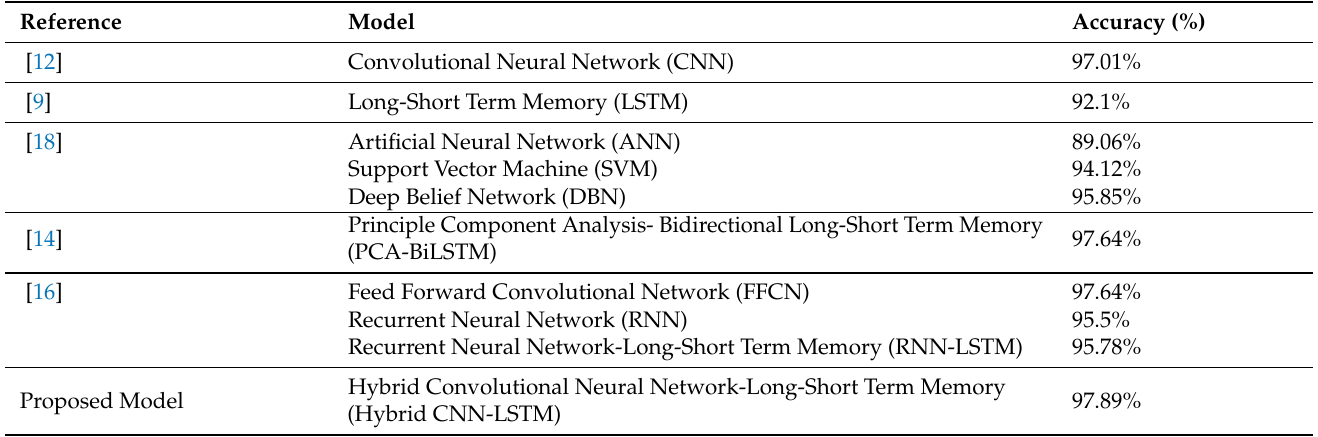
Table 4. Comparison of accuracy of proposed model with state-of-the-art